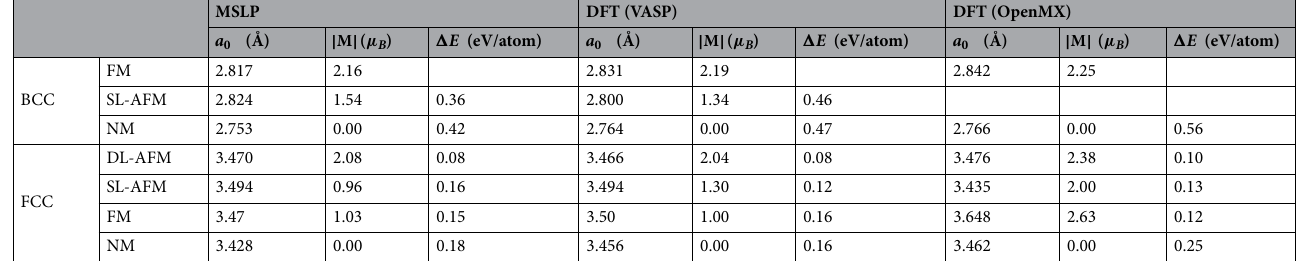
Table 1. The equilibrium lattice constant a 0 , the magnitude of spontaneous magnetic moment relative energy difference with respect to the BCC ground state (cid:31) E calculated using our machine-learned spin- lattice potential (MSLP) for iron at non-magnetic (NM), ferromagnetic (FM), single layer antiferromagnetic (SL-AFM), and double layer antiferromagnetic (DL-AFM) states in BCC and FCC structures. DFT calculations using VASP and OpenMX are shown for comparison. Details are in Supplementary